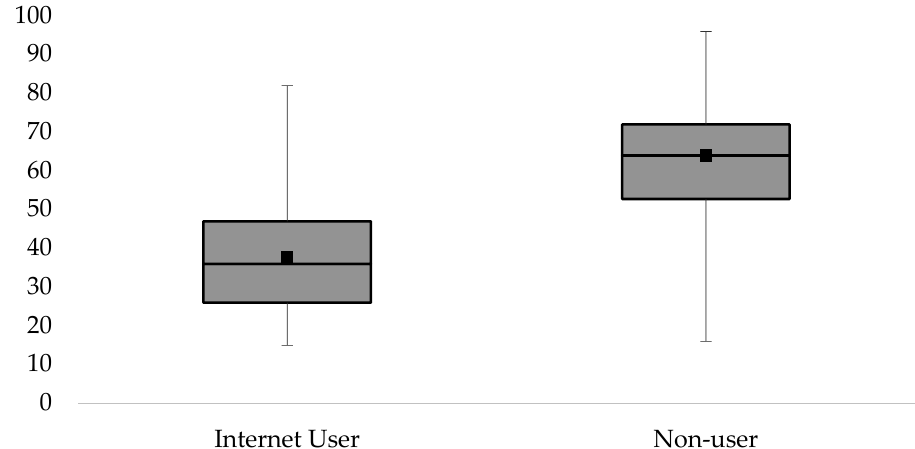
Figure 3. Box plot of ages: Internet users in relation to non-users. Source: ERC2015—The new dynamics of audio-visual consumption in Portugal; n = 1018.